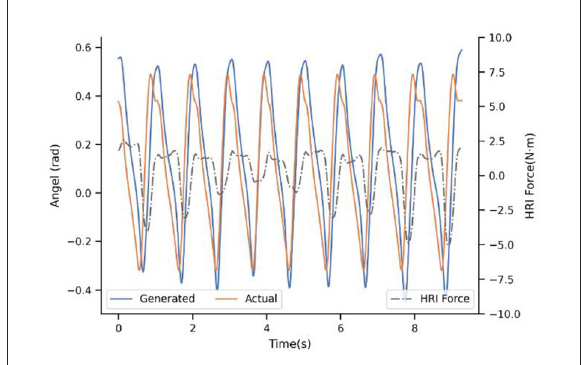
FIGURE9 Experimental result of subject 4 # with strategy PIP-I.